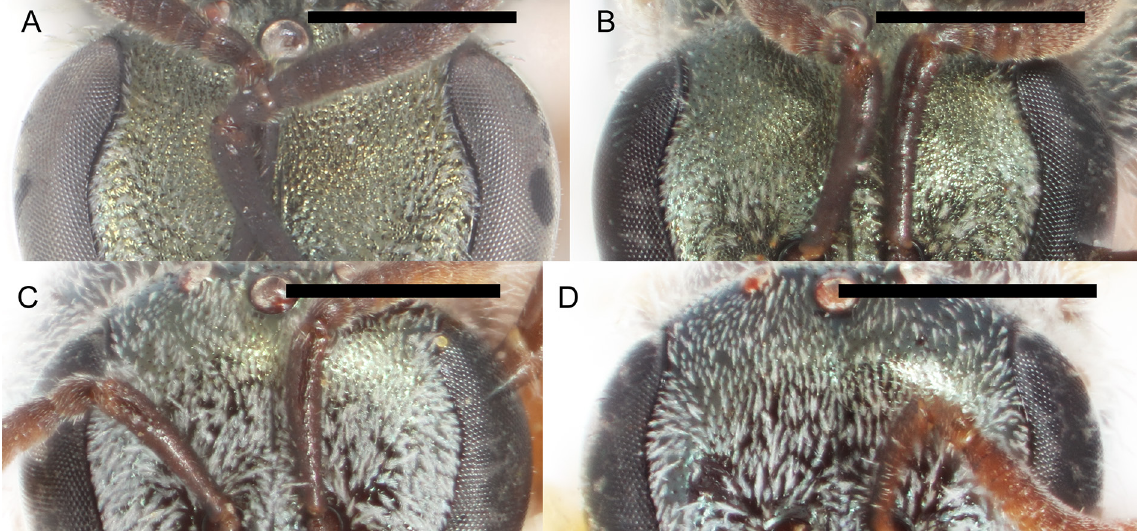
Fig. 94. Variation in frons punctation. A . Lasioglossum ( D. ) tessellatosum sp. nov., ♀, reticulate- punctate to ruguloso-punctate with crowded punctures. B . L. ( D. ) meteorum sp. nov., ♀, fine and dense but distinctly separated punctures. C . L. ( D. ) julipile sp. nov., ♀, moderately sparsely punctate. D . L. ( D. ) perditum sp. nov., ♀, very sparsely punctate. Scale bars: 0.5